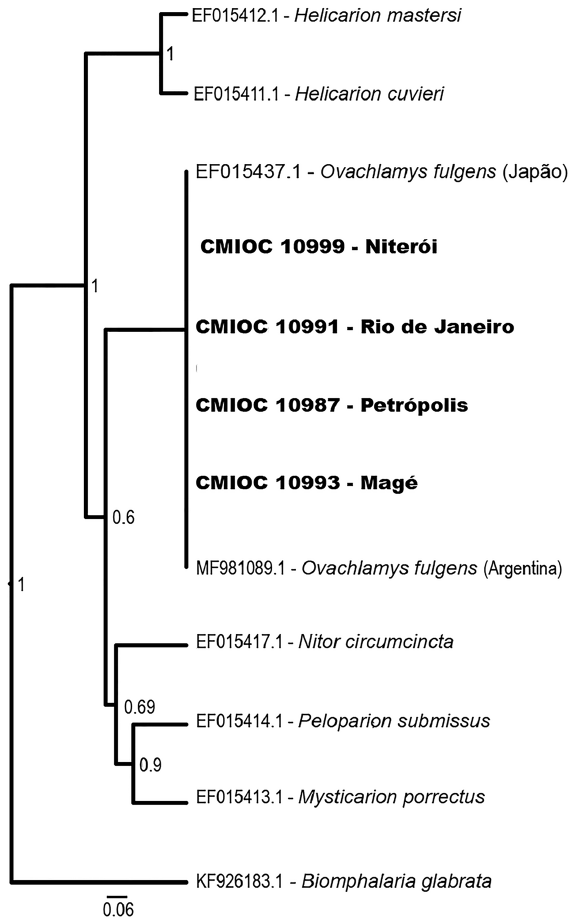
Figure 8. A phylogenetic species tree reconstructed with 625 base pair of COI sequences of seven taxa classified in Helicarionoidea and sequences of four individuals from Rio de Janeiro. Posterior probabilities above 0.6 are show for key